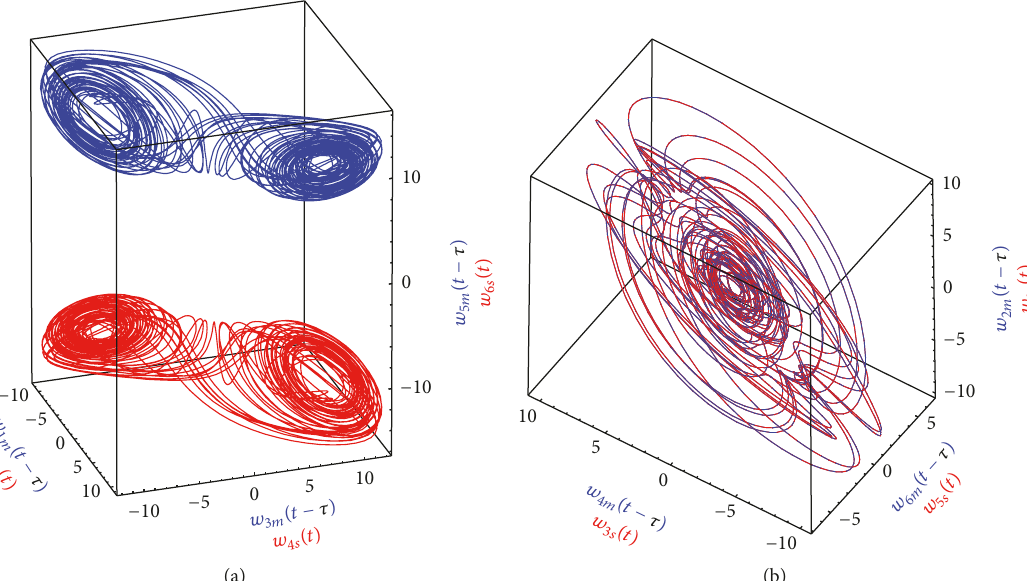
Figure 6: The attractors of systems (34) and (35). (a) Attractor of the main system has the opposite shape of the slave system. (b) Attractor of the main system has the similar shape of the slave system.